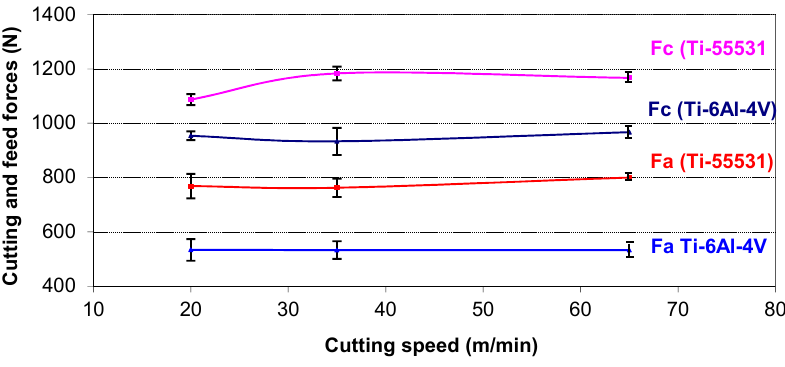
Figure 6. Cutting forces obtained for Ti-6Al-4V and Ti-55531 with tool geometry